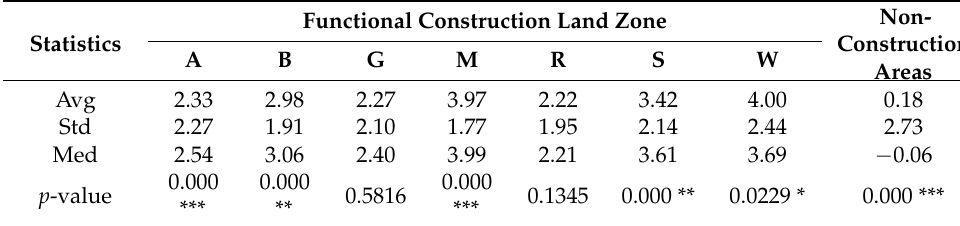
Table 4. The statistics and Shapiro-Wilk test of DST in urban land ( ◦ C).